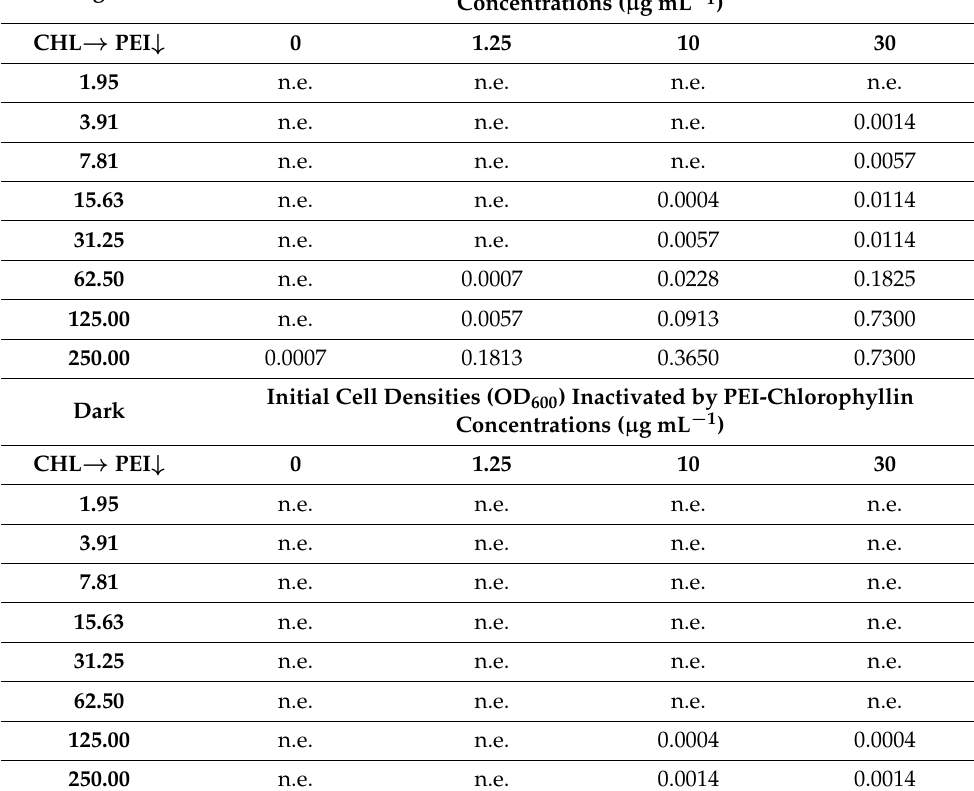
Table 2. Effect of different concentrations of PEI and chlorophyllin on different cell densities of E. coli DH5 α incubated under a blue-red light source (12.7 mW cm − 2 ) and in darkness for 24 h. The maximum cell densities that are entirely eradicated at a given combination of PEI (vertical concentration gradient in µ g mL − 1 ) and chlorophyllin (horizontal concentration gradient in µ g mL − 1 ) are presented (n.e.: no